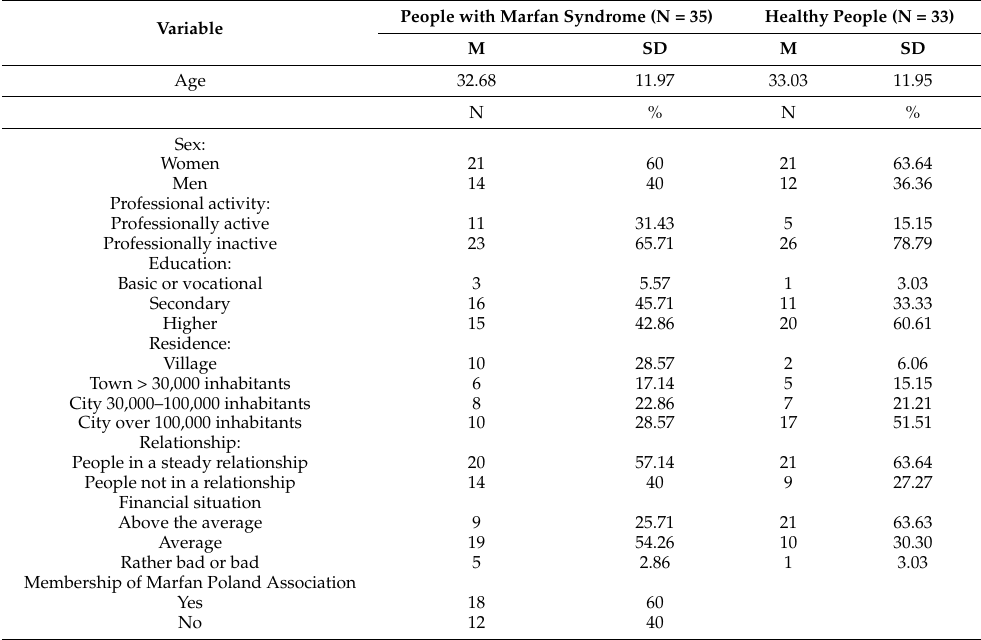
Table 1. Demographic data concerning both studied groups.